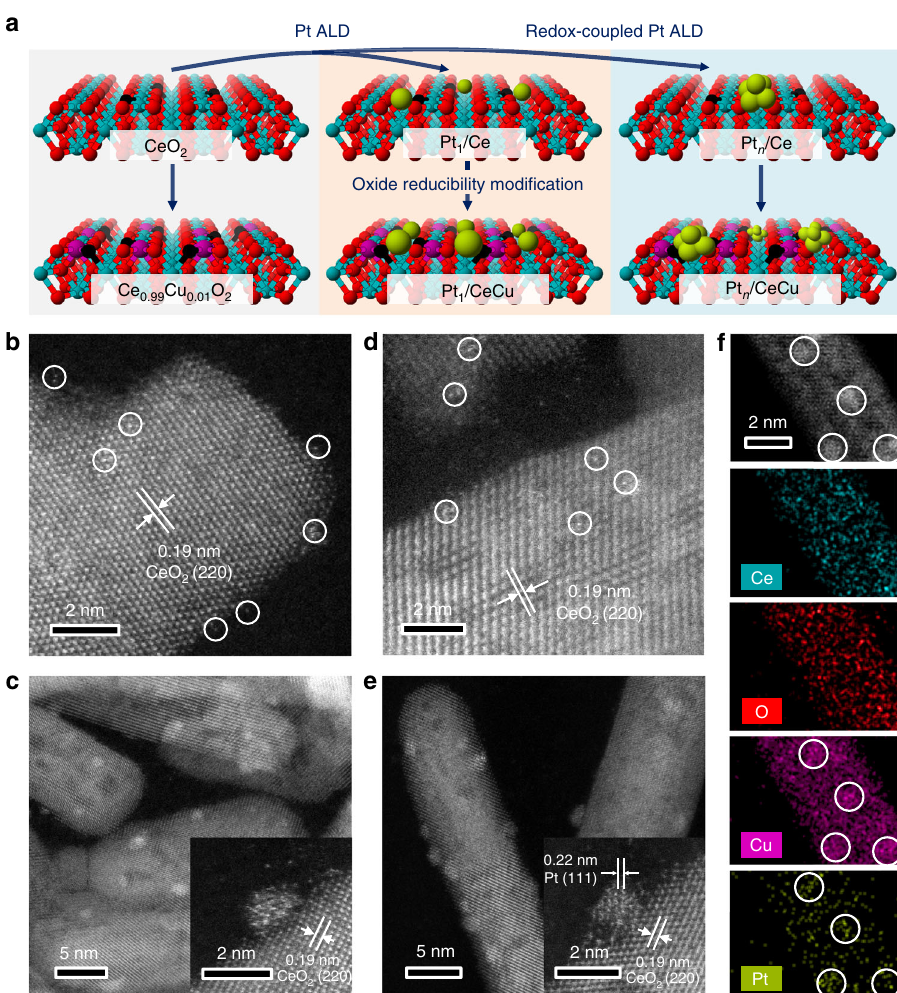
Fig. 1 Preparation processes and electron microscopy characterizations of catalysts. a Schematic illustration of preparation processes for supported Pt catalysts, with Ce, O, Pt, and Cu atoms shown as Red, Cyan, Green, and Purple, respectively. HAADF-STEM images of ( b ) Pt 1 /Ce, ( c ) Pt n /Ce, ( d ) Pt 1 / CeCu, and ( e ) Pt n /CeCu. Inserts in ( c ) and ( e ) show HAADF-STEM images of the Pt n /Ce and Pt n /CeCu interfaces. Atomically dispersed Pt atoms are marked in ( b ) and ( d ) by white circles. f EDS analysis of Pt n /CeCu shows the locations of Ce, O, Cu, and